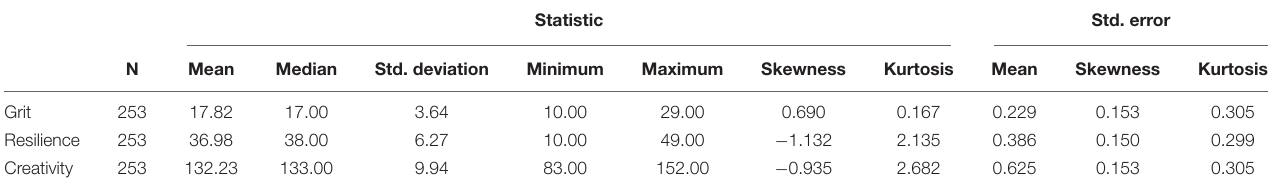
TABLE 3 | Statistics of the participants with regard to resilience, grit, and creativity after removing the outliers. Statistic Std. error